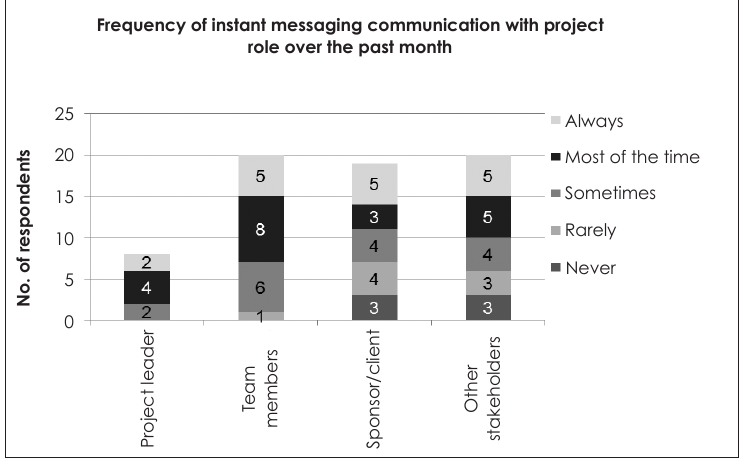
Figure 3: Frequency of IM communication with the various project